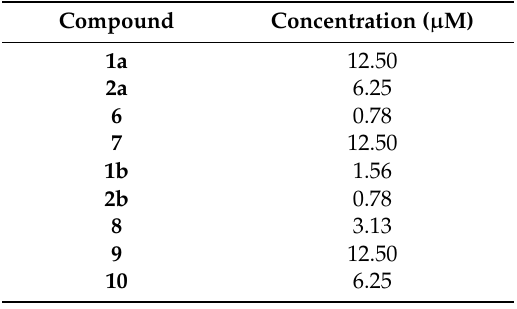
Table 2. Maximal compound solubility in